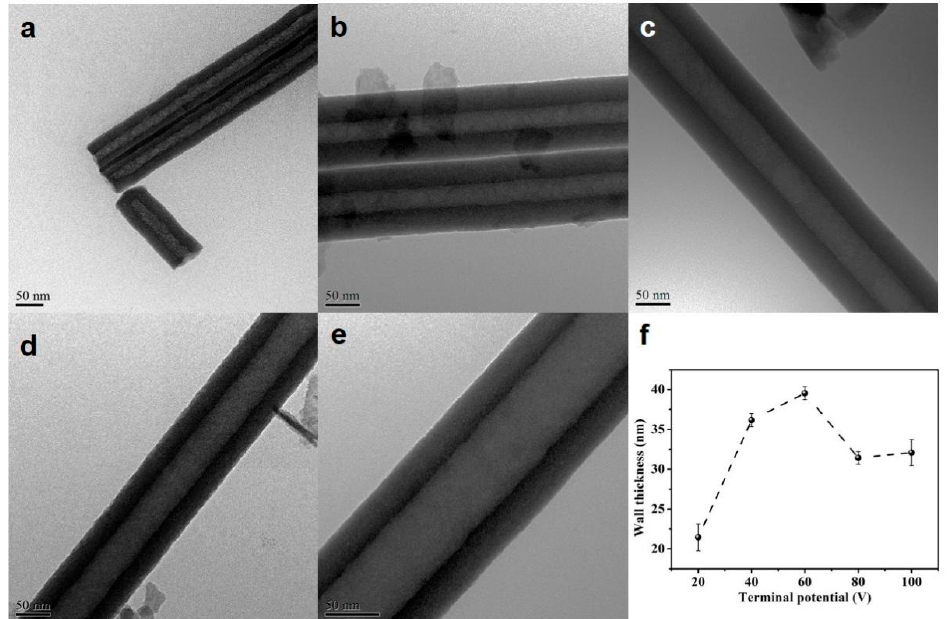
Figure 2. ( a – e ) TEM images of the HEO nanotubes formed under various potentials: ( a ) 20 V, ( b ) 40 V, ( c ) 60 V, ( d ) 80 V and ( e ) 100 V after anodization for 4 h in the ethylene glycol solution containing 0.1 mol/L NH 4 F and 10 vol.% of water; ( f ) the changes in nanotube wall thickness with applied potential.